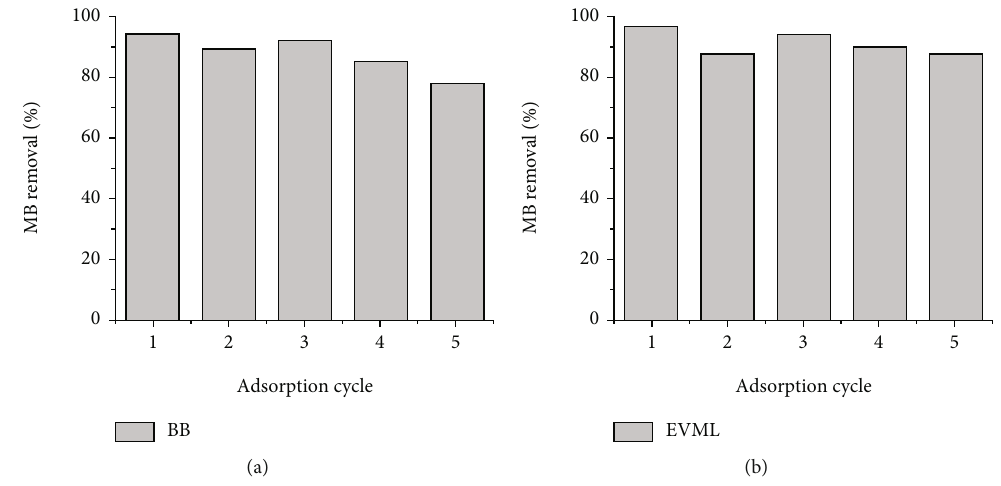
Figure 10: Adsorption cycle of (a) BB and (b) EVML for MB removal. Table 5: Comparative presentation of costs of